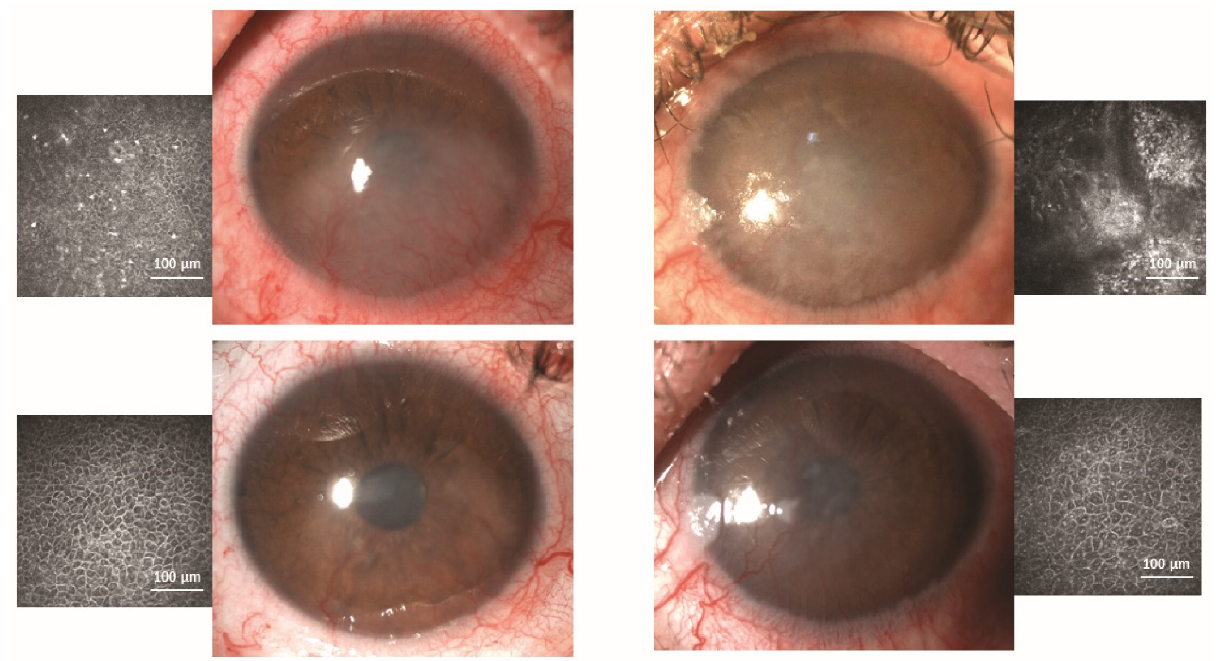
Figure 4. Bilateral limbal stem cell deficiency due to Stevens–Johnson syndrome. The right eye ( left panel ) was randomized to receive allogeneic limbal stem cell transplantation (CLET), and the left eye ( right panel ) received a mesenchymal stem cell transplantation (MSCT). The upper panels show that both corneas have a mixed epithelial phenotype as imaged by in vivo confocal microscopy. The lower panels show the same eyes after 12 months. Both corneas have an epithelial phenotype in the central cornea. Both transplants were successful.